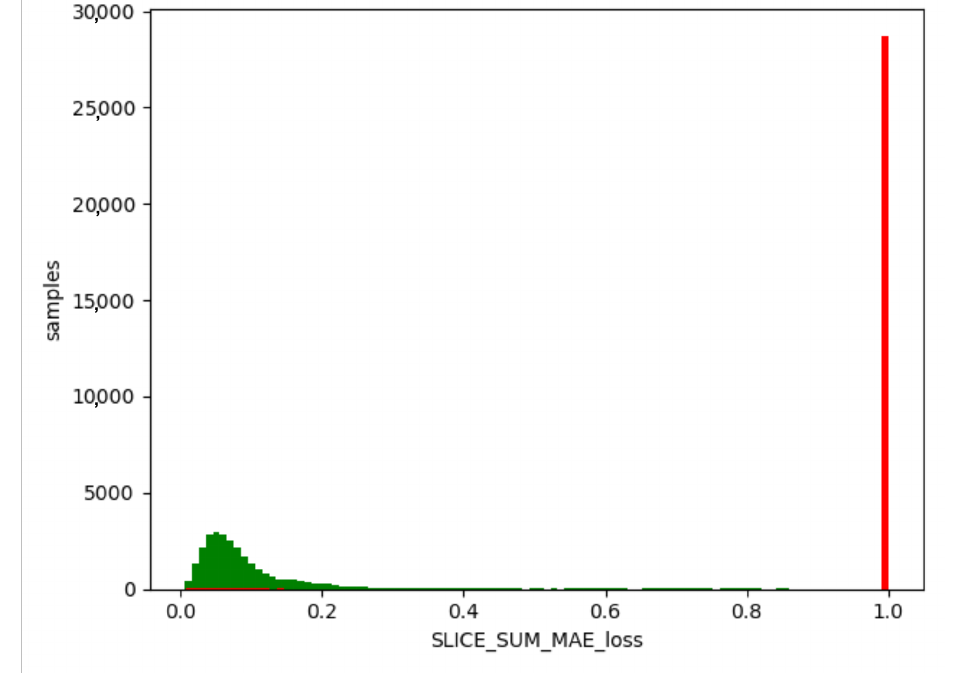
Figure 15. WSN-DS evaluating set. Green indicates normal data and red indicates abnormal data.